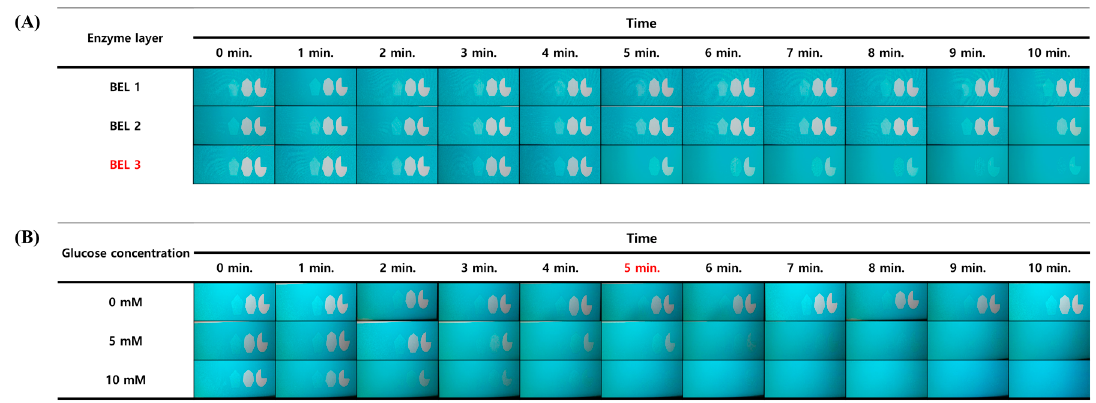
Figure 5. The resulting images of the optimization test for biosensing of surface modifications: ( A ) A 2.5 mM sample of glucose is assayed by means of the GOx/HRP catalysis. The one, two, and three enzyme layers were compared, and the images with color development were registered every 1 min up to 10 min. As the immobilized enzyme layer increases, the signal guides significantly changed. ( B ) The result of testing the reaction time by means of the three-enzyme layer. With reaction time at 5 min, the signal guides are clearly distinguished in accordance with the applied glucose concentration.